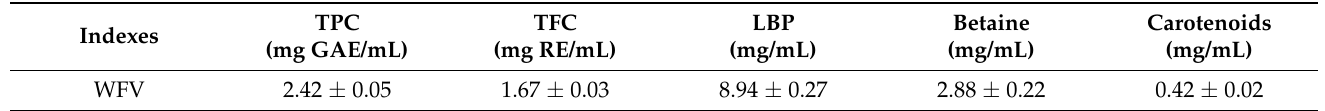
Table 2. Content of functional component and antioxidant activity in WFV.